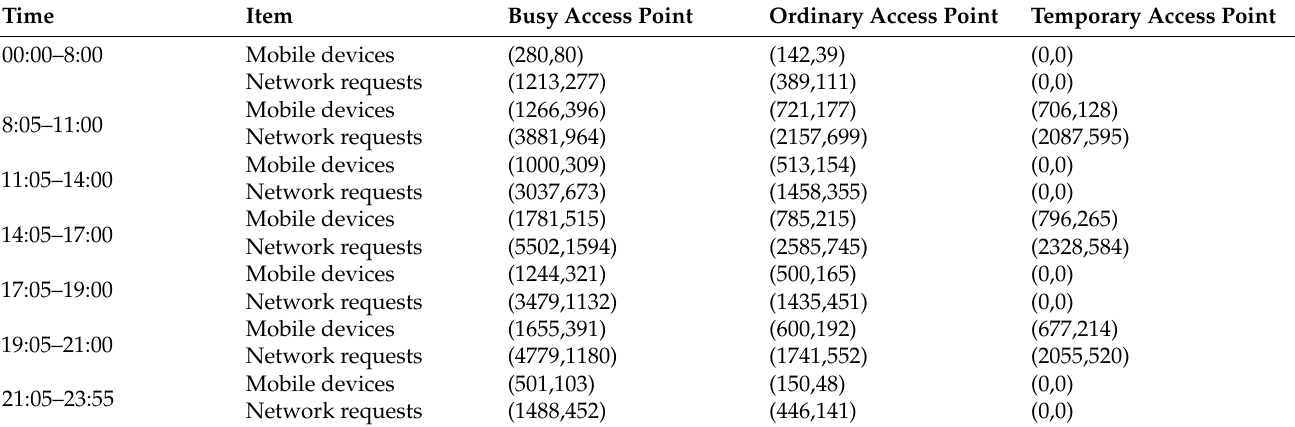
Table 4. Number of mobile devices and network requests at different access